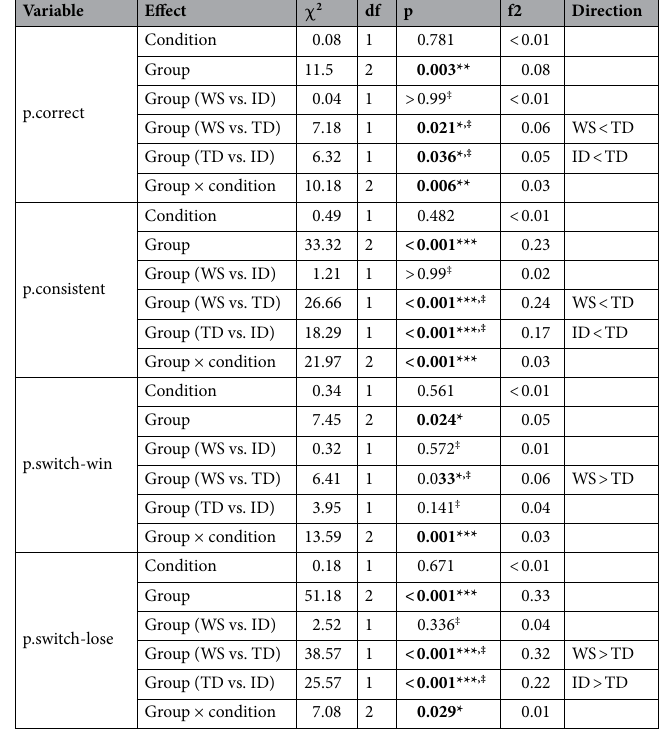
Table 2. Results from linear mixed effects models (LMMs) of choice behavior variables. Significant values are in bold. WS Williams syndrome, ID intellectual disability, TD typically developed adults. *p < 0.05, **p < 0.01, ***p < 0.001; ‡ p-values are Bonferroni-corrected for multiple comparisons.